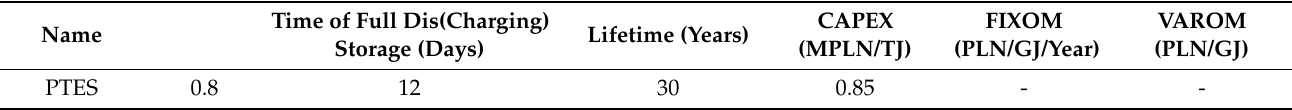
Table 4. Data of heat storage technology.